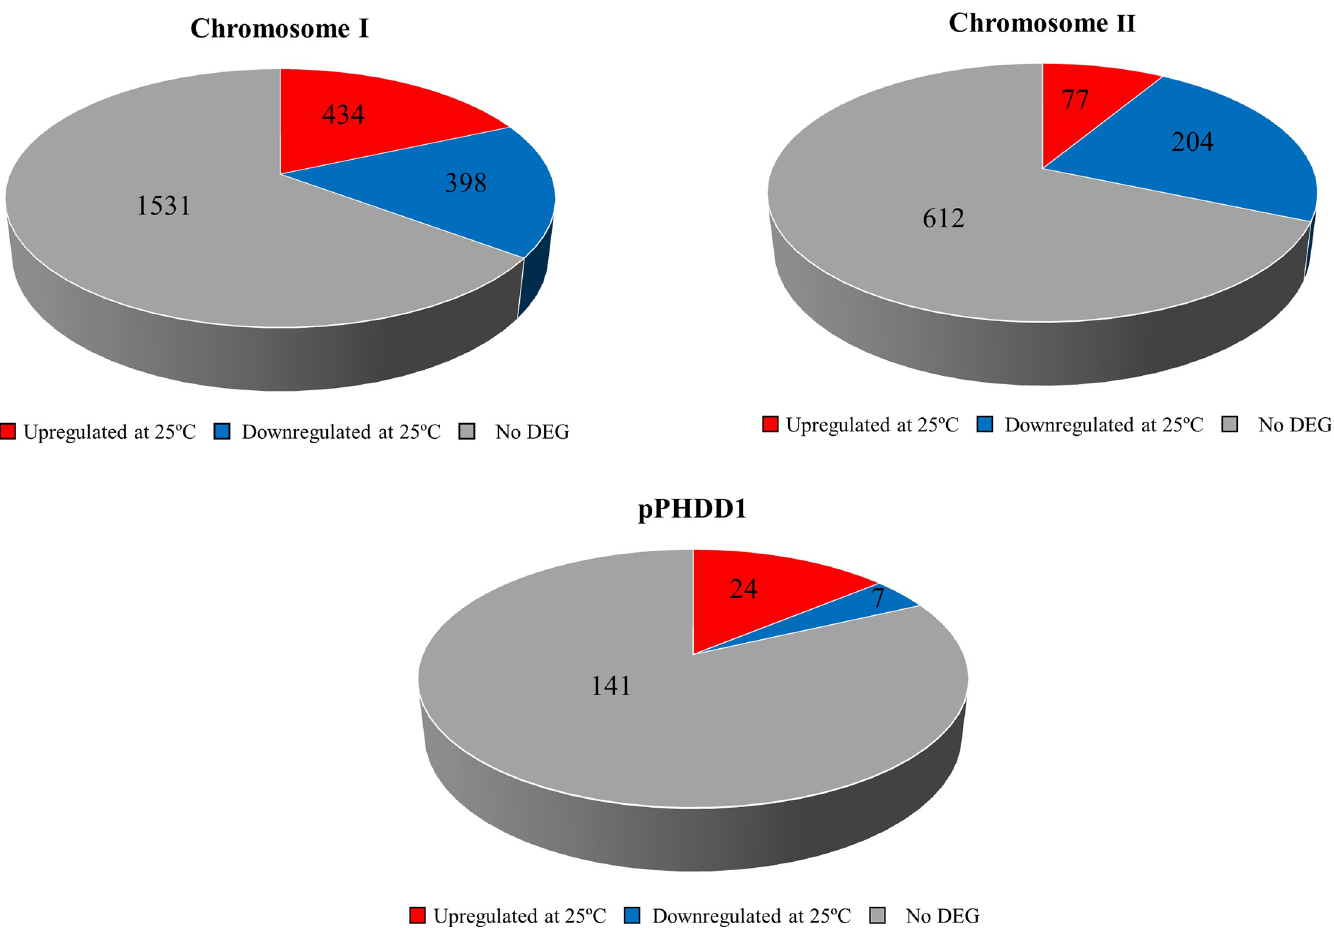
Fig 3. Graphical representation of DEGs distribution among the two Pdd chromosomes and pPHDD1 virulence plasmid. Numbers denote DEGs upregulated at 25˚C (red), downregulated at 25˚C (blue), and genes not differentially regulated (grey).